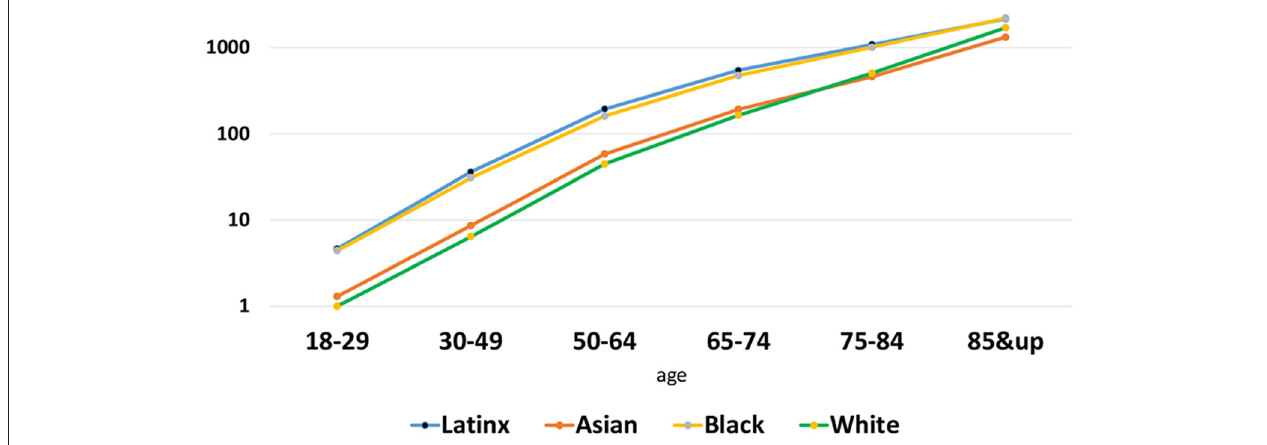
FIGURE 2 | Log of Cumulative COVID-19 deaths/100,000 population, January 2021.